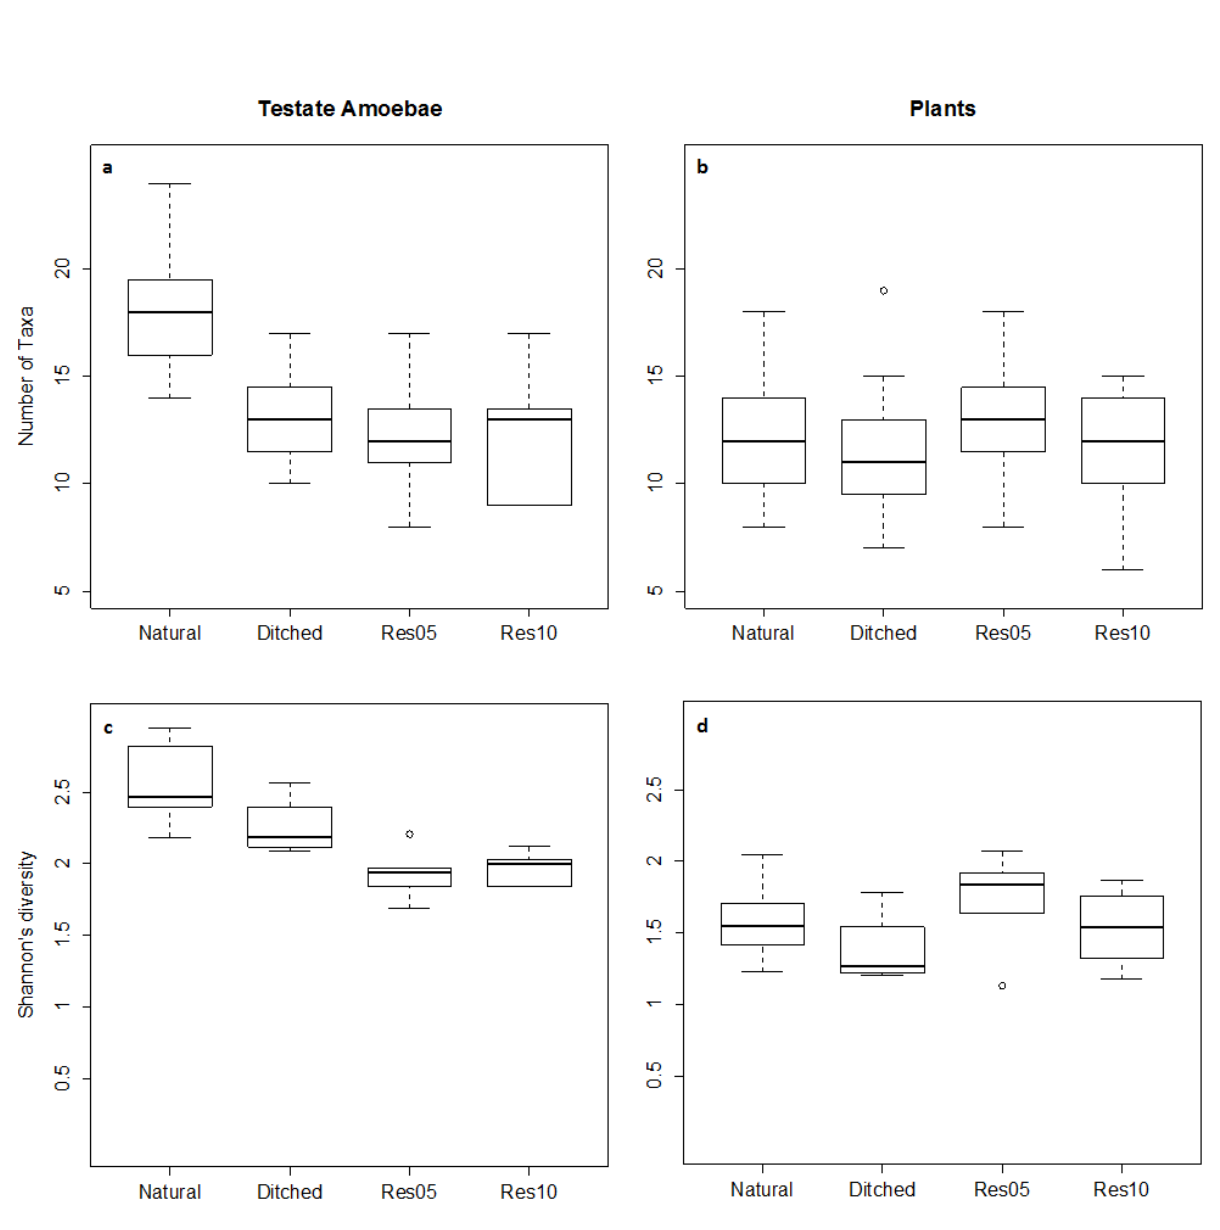
Figure 2. Taxon richness boxplots for testate amoebae (a) and vegetation (b). Shannon’s diversity boxplots for testate amoebae (c) and vegetation (d) for each management class. Circles: outliers, upper whisker: maximum value excluding outliers, upper box line: upper quartile, middle line inside box: median, lower box line: lower quartile, lower whisker: minimum value excluding outliers. Res05: peatlands restored 3–7 years ago; Res10: peatlands restored 9–12 years